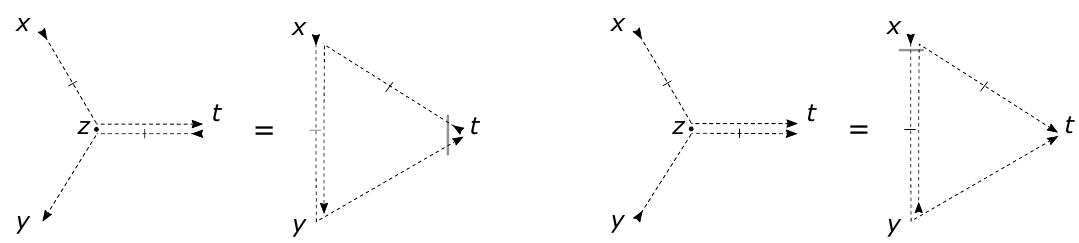
Figure 8 . Star-triangle relations for “opposite flow” (left) and “same flow” (right), where the order of matrices σ , ¯ σ in the product is given by the arrows and the position of ¯ σ is denoted by the barred lines. The action of the R -matrix is represented along the spinorial structure by a grey line.